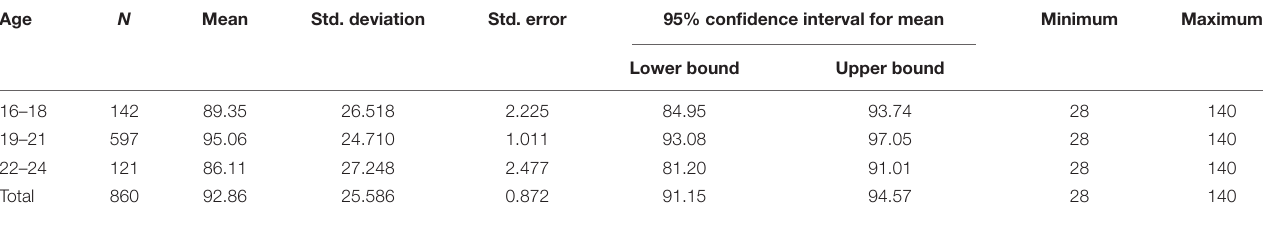
TABLE 6 | Descriptive analysis for